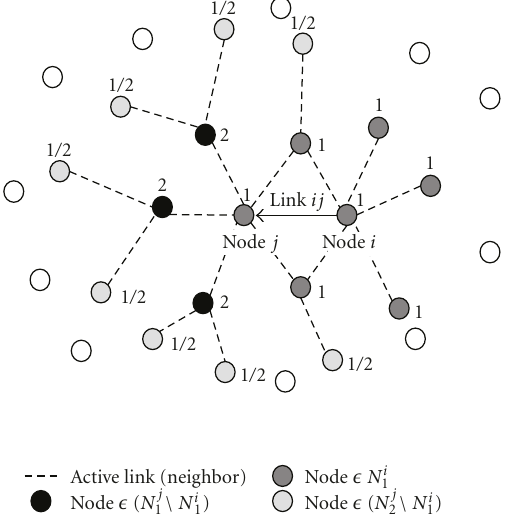
Figure 1: Example of WCIMs channel occupancy algorithm. The one hop neighbors of the transmitter i are weighted by 1, the hidden nodes of link ij by 2 and the two-hop neighbors of the receiver j by